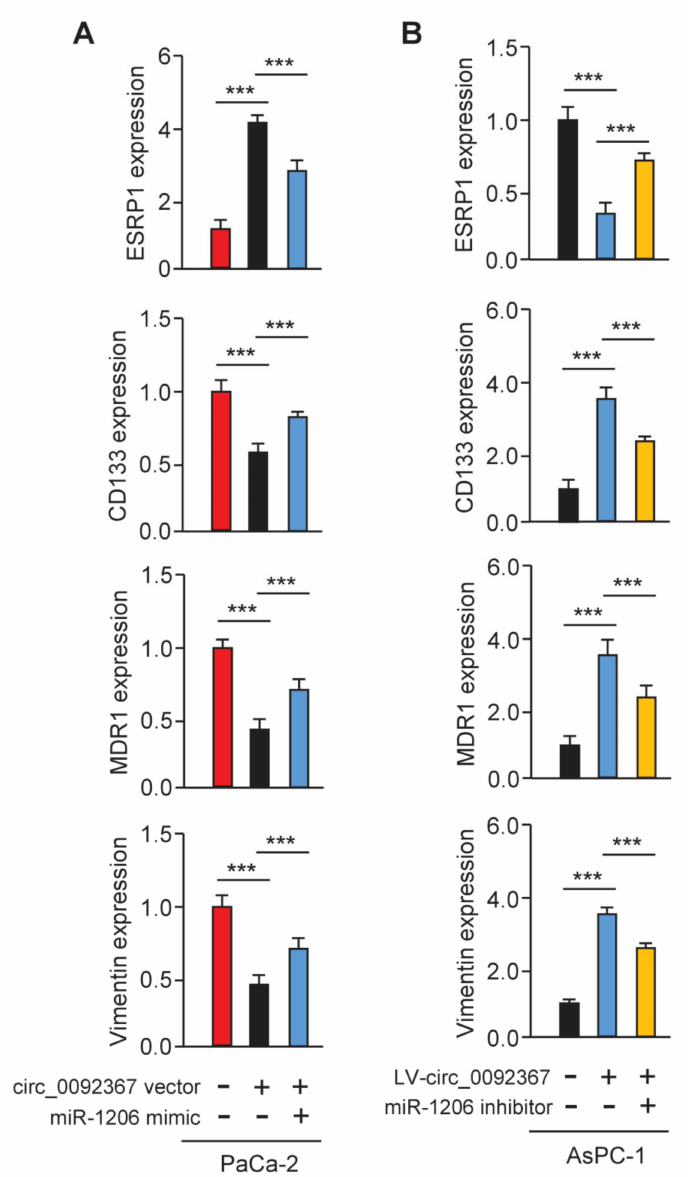
Figure 9. Circ_0092367 Regulates the Expression of ESRP1 via MiR-1206. ( A ) qRT-PCR analysis of ESRP1 , CD133 , MDR1, and Vimentin levels in circ_0092367-overexpressing PaCa-2 cells overexpress- ing miR-1206 mimic and in control cells. ( B ) qRT-PCR analysis of ESRP1 , CD133, MDR1, and Vimentin expression in circ_0092367-knockdown AsPC-1 cells with miR-1206 silencing and in control cells. The experiments in ( A , B ) were repeated three times independently with similar results. *** p